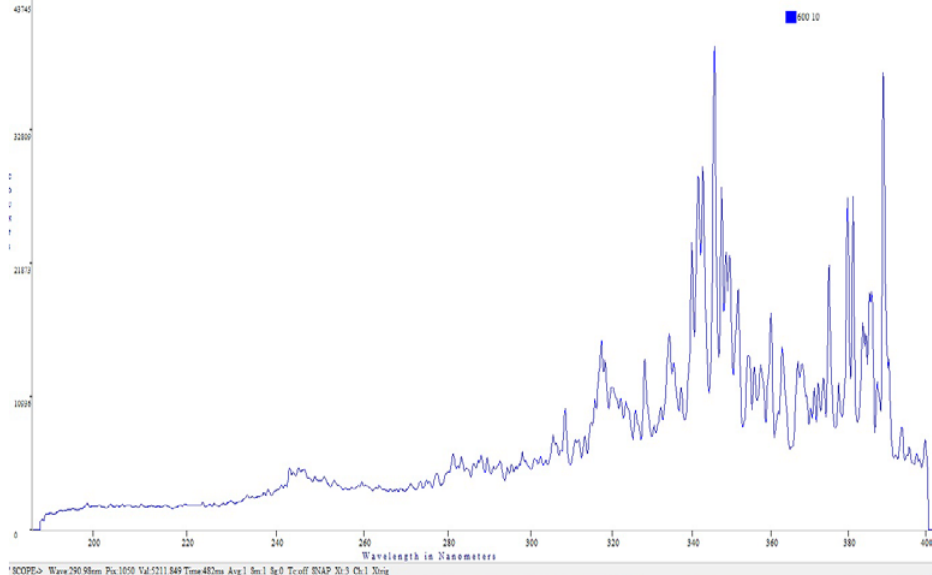
Fig.8: Emission spectra of laser energy 600 mJ with 10Hz repetition